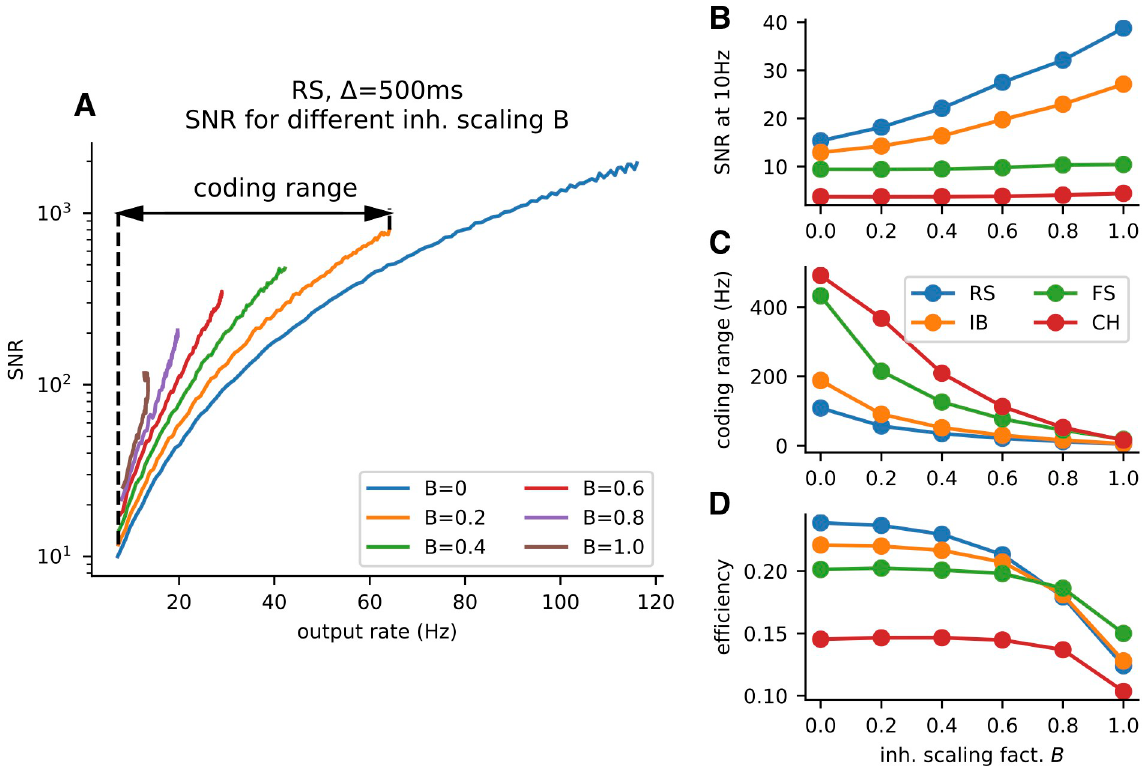
Fig 4. The effect of inhibition on metabolically efficient information transfer. (A) Signal-to-noise ratio (SNR, Eq (25)) of the RS neuron’s response as a function of the mean post-synaptic firing rate r ( x ) (Eq 26). Higher inhibition leads to a higher SNR, however, also to a lower coding range. The coding range for B = 0.2 is visualized in the plot. (B) The SNR at 10 Hz at different inhibition levels for all four neurons. The effect of the decreased membrane potential fluctuations on the FS and CH neurons is negligible, as opposed to the RS and IB neurons. (C) Decrease of the coding range with inhibition. (D) The metabolic efficiency in bits per spike (Eq (18)). The initial increase in the efficiency is almost negligible, however, the drop for B = 1 caused by the narrow coding range is apparent. The time window used for this figure is Δ = 500 ms.